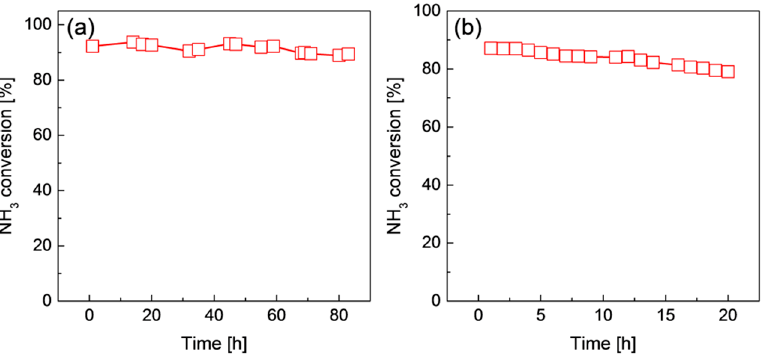
Figure 8. Time course of CS ‐ 60 ( a ) and SS ‐ 40 ( b ) Ru/graphene nanocomposites for ammonia decomposition at 450 and 500 °C.